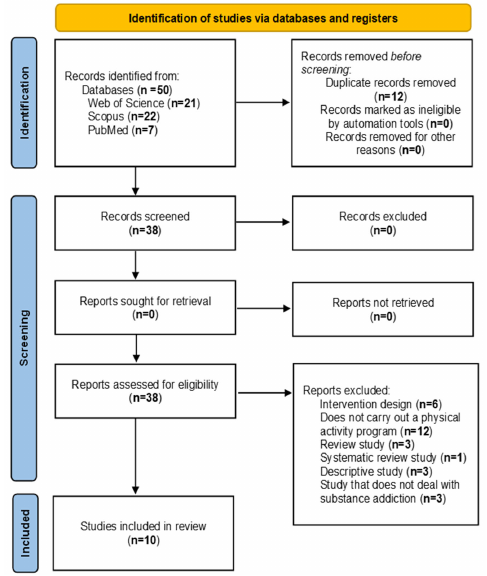
Figure 1. Flowchart of the systematic review process according to the PRISMA protocol declara ‐ tions. 2.4. Data Extraction From the titles, abstracts, keywords and full ‐ text articles, in relation to the questions of interest, the data were extracted as they were found in their respective studies